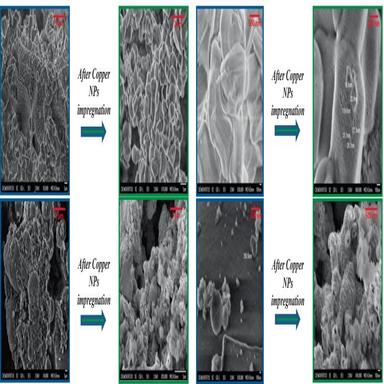
SEM images of raw MCM-41 material and Cu-MCM-41 (upper line) material and SEM images of raw MCF material and Cu-MCF material (lower line).